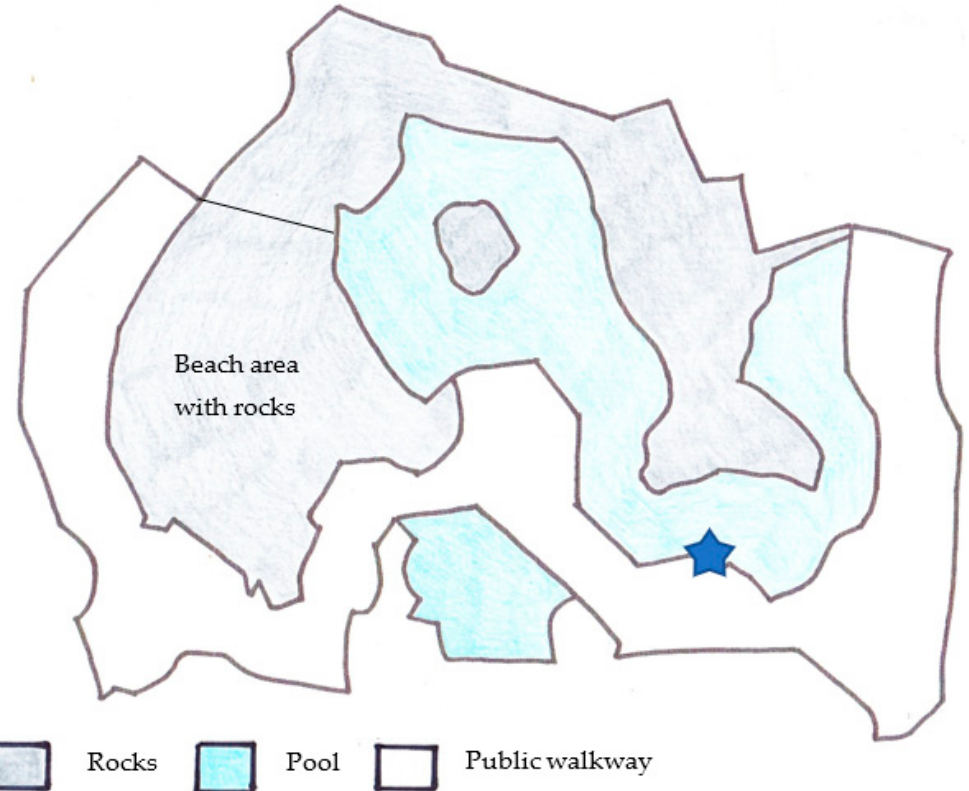
Figure 1. A schematic drawing of the South American fur seals enclosure at Bristol Zoo Gardens [23]. Blue star indicates where observations were made from.